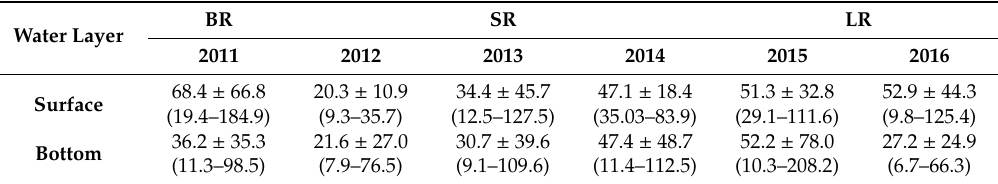
Table 1. The ratio of total nitrogen to total phosphorus (N:P) at the surface and bottom layers of Swarz˛edzkie Lake during the studied period (mean, minimum and maximum values) (BR—before restoration, SR—sustainable restoration, LR—limited